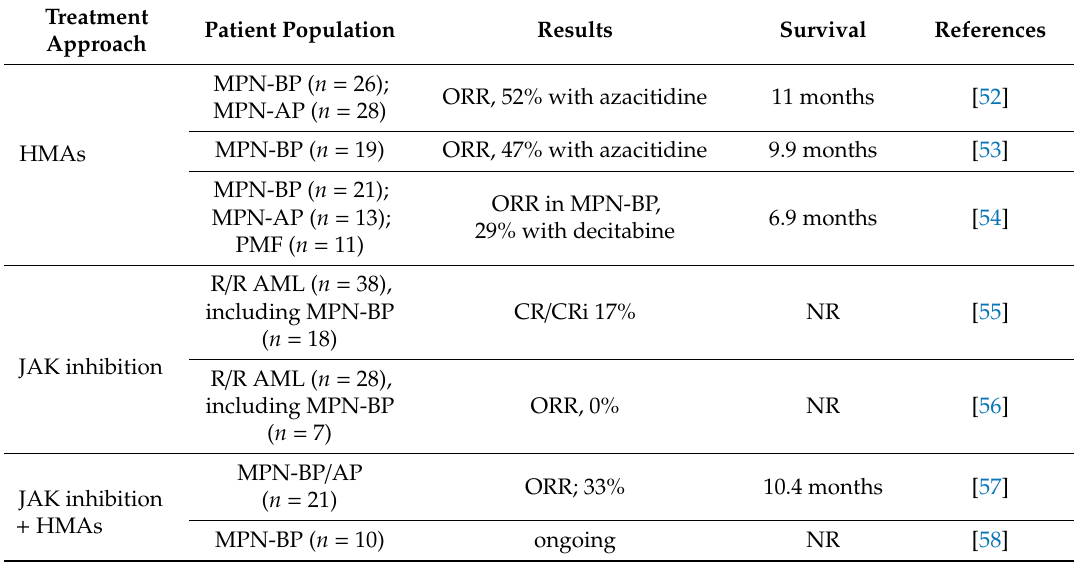
Table 2. Conventional therapeutic